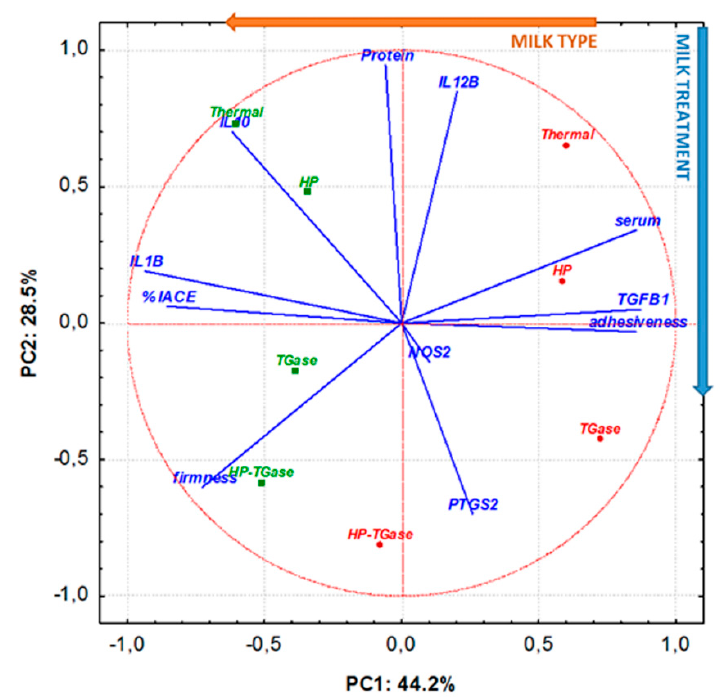
Figure 3. Principal component analysis (PCA) biplot for the investigation of the effect of milk type and milk treatment on the quality and bio-functional properties of yoghurt samples prepared from bovine (red cycles) or ovine (green squares) milk (the codes Thermal, TGase, HP, and HP–TGase represent the treatment of milk).